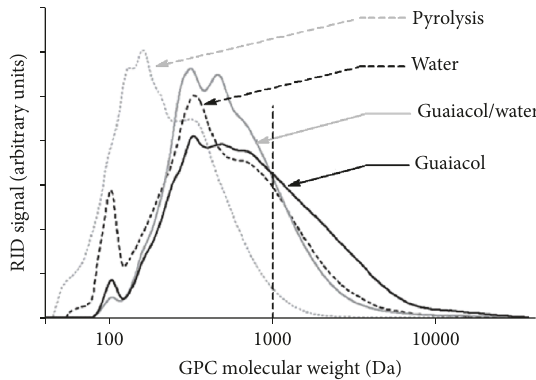
Figure 1: GPC results of the isolated biooils with guaiacol, guaia- col/water, and water, respectively